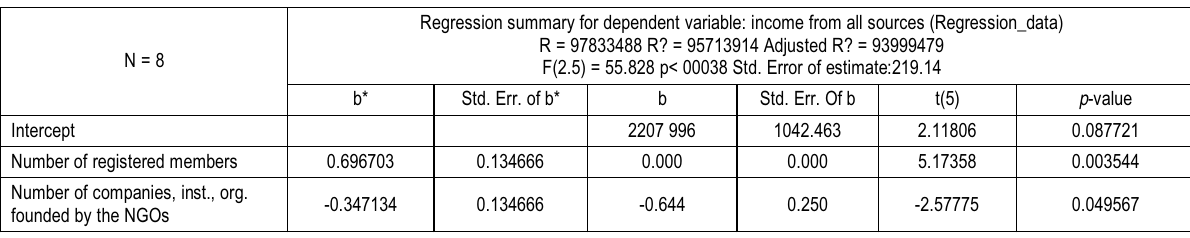
Table 7.The linear model of multiple regression describing correlation and regression relation ofthe index of funding of NGOs and quantitative